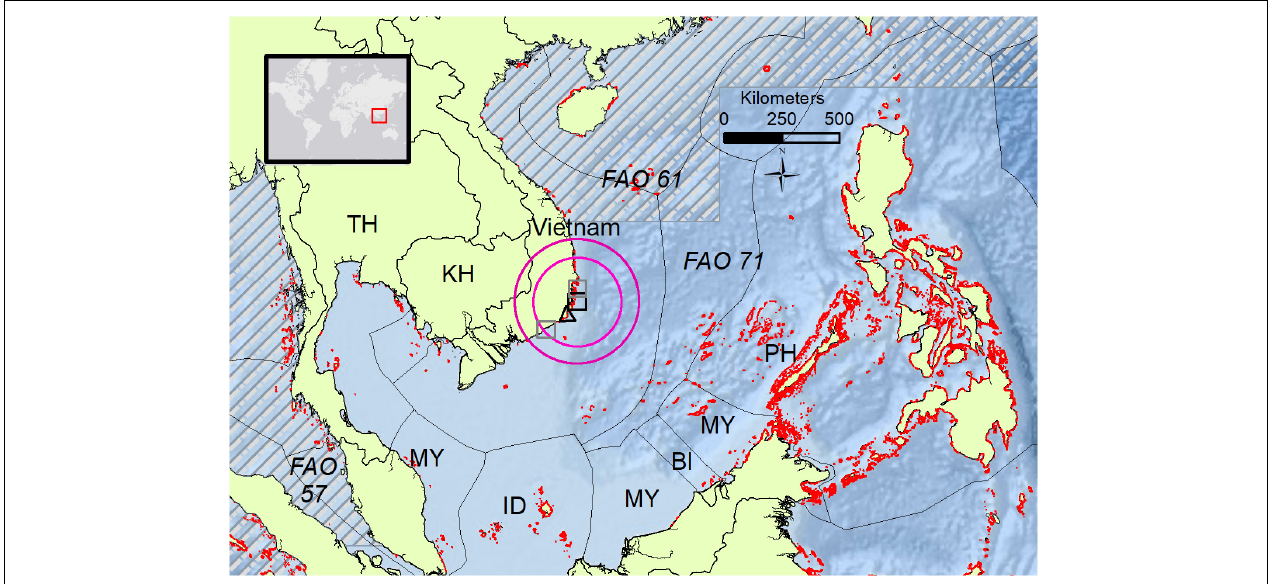
FIGURE 3 | Map displaying the country of export (Vietnam) and surrounding waters (Flanders Marine Institute [VLIZ], 2021), exclusive economic zones (EEZ) of neighboring countries (Flanders Marine Institute [VLIZ], 2014), FAO recognized fishing zones (FAO, 2014), known coral reefs (Institute for Marine Remote Sensing et al., 2011), and symbols representing locations of interest. The World map in the upper left corner contains a red square that indicates the regional area depicted in the main map figure. FAO major fishing zones are indicated with italicized font and dashed horizontal gray bars for zone 57 and 61, whereas FAO fishing zone 71 (catch region for the implicated product) is without horizontal hashing. The estimated catch area (based on the factors discussed in Section “Source product location of capture”) for the product implicated in CP is within the two pink rings, inner and outer pink rings represent approximately 220 and 330 km distance from the coastal area of the processing plant for the exported product (black square). Pink circles represent a “ best guess ” area for where the implicated fish were likely harvested from based on the EEZ (black dotted line) surrounding the exporting country, the ecology of L. bohar , and distance restrictions of the modern-large class local fishing vessels (Tun et al., 2005). Gray squares are locations of CP outbreaks attributed to L. bohar in 2014 and 2016, black triangle is the region of Cau Island Binh Thuan, Vietnam, where Gambierdiscus toxicus was collected (Roeder et al., 2010). Country codes (BI, Burundi ; ID, Indonesia ; KH, Cambodia ; MY, Malaysia ; PH, Philippines ; TH, Thailand) were based on the International Organization for Standardization (Patrias and Wendling, 2007).